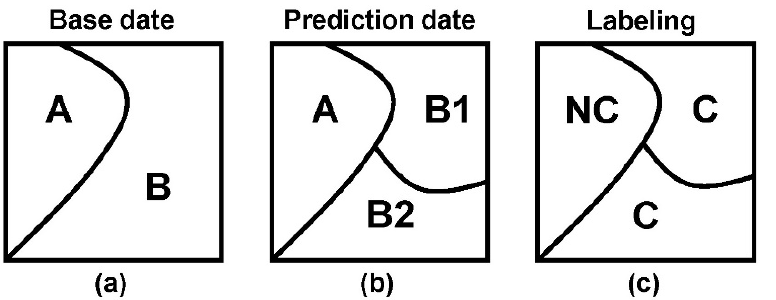
Figure 2. Illustration of object-based change detection through multi-temporal segmentation: ( a ) Two objects, A and B, at the base date; ( b ) three objects, A, B1, and B2, at the prediction date, where object B at the base date is sub-divided into two objects, B1 and B2; ( c ) labeling of the changed and non-changed objects, where NC and C indicate the non-changed and changed objects, respectively.